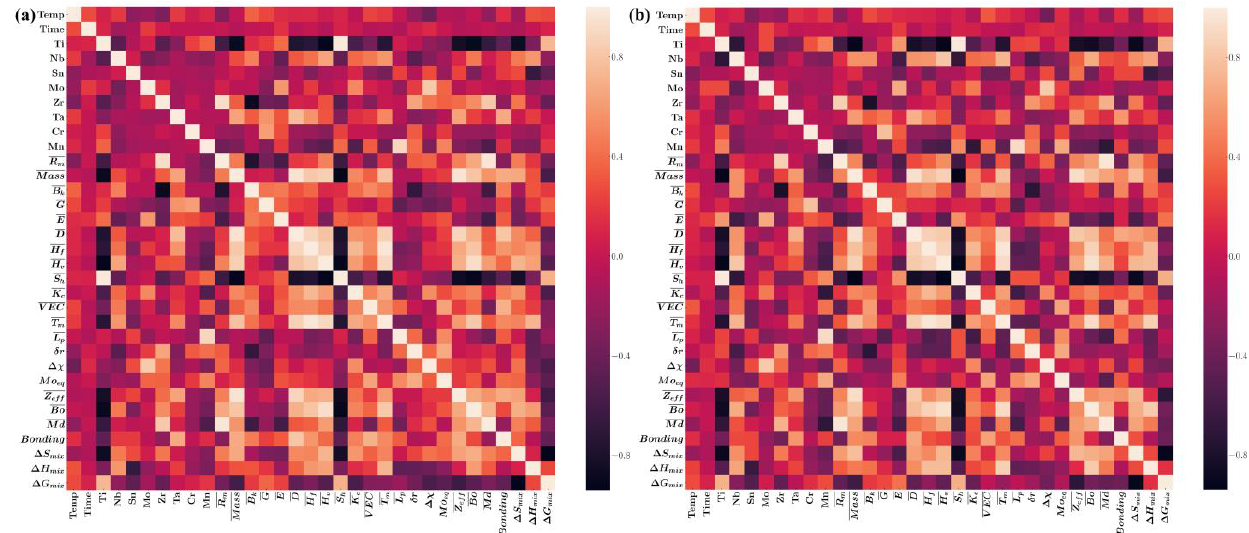
Figure 2. The heat map describes the correlation between the features of the datasets. The darker the color, the stronger the positive correlation between the features and characteristics; the lighter the color, the stronger the negative correlation: ( a ) the microstructures dataset and ( b ) the Young’s modulus dataset.